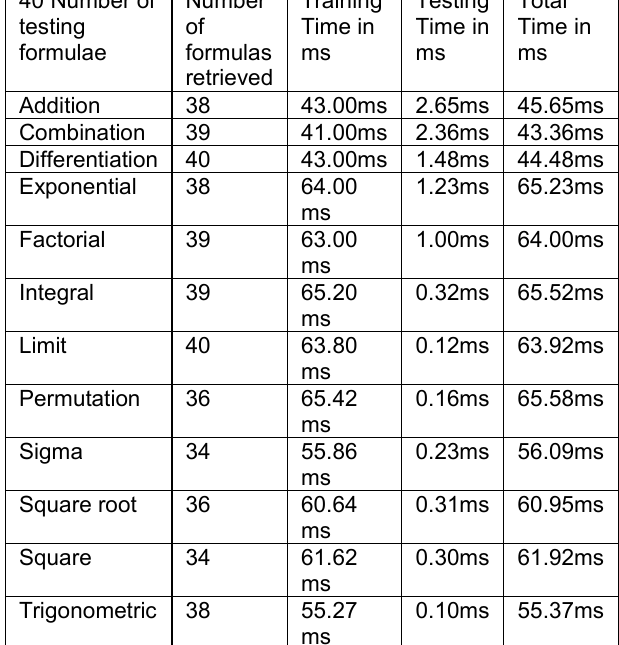
Table 5. The above tabulated value represents time taken for retrieving matched formulae with Tensorflow from a document of 40 samples along with testing time and training time.